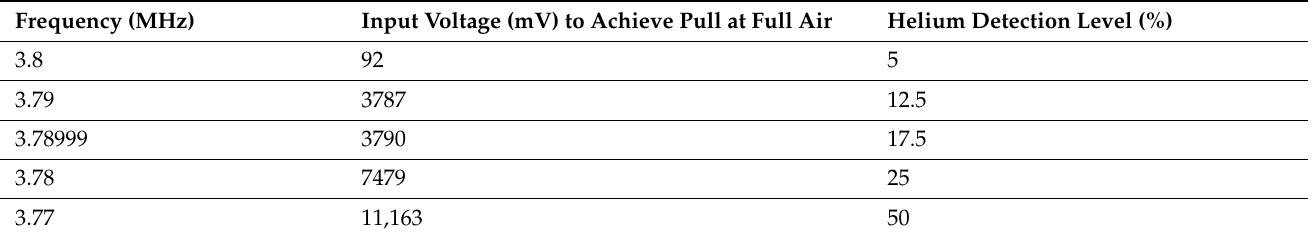
Figure 6. The detection of 5% helium ( ε r = 1.00048) at 3.8 MHz (while the pull-in event happened at 0% helium ( ε r = 1.0005) condition).